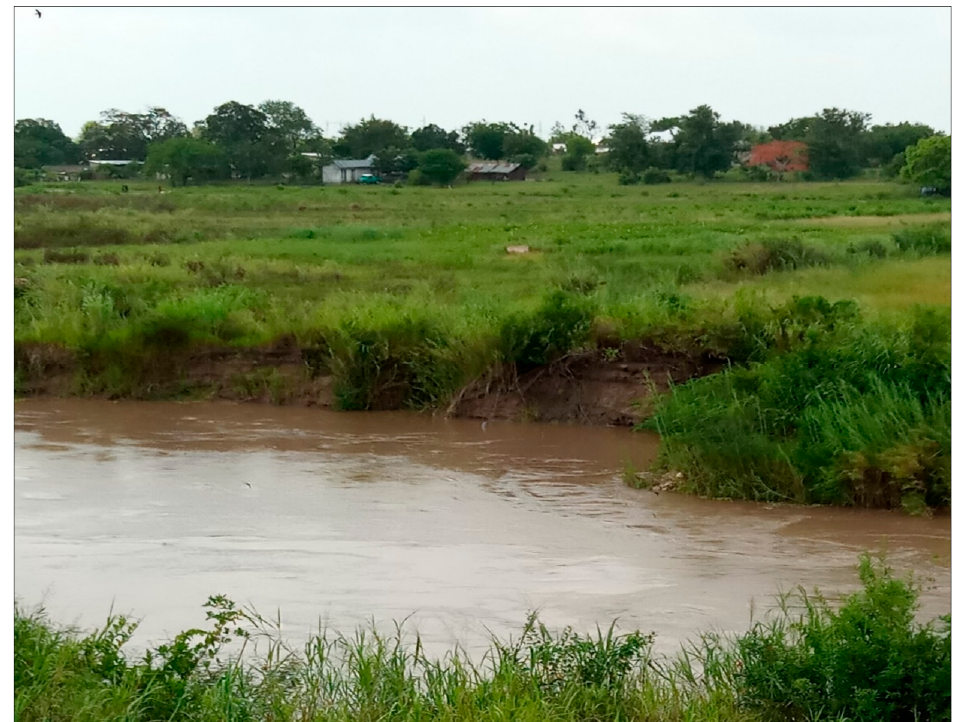
Figure A1. The upper part of the Ruvu sub-basin (the Uluguru Mountains).